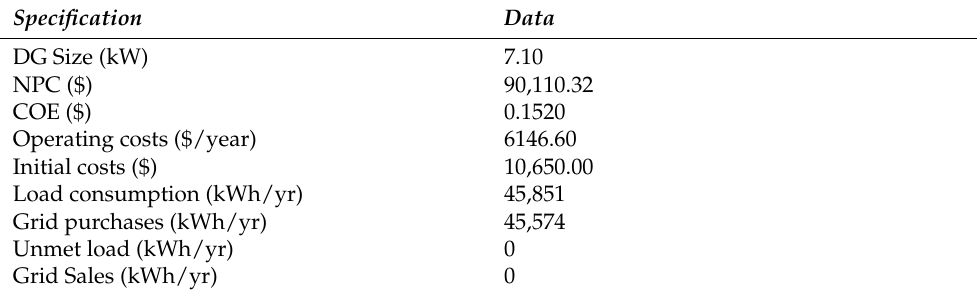
Table 6. Parameters for system 1.